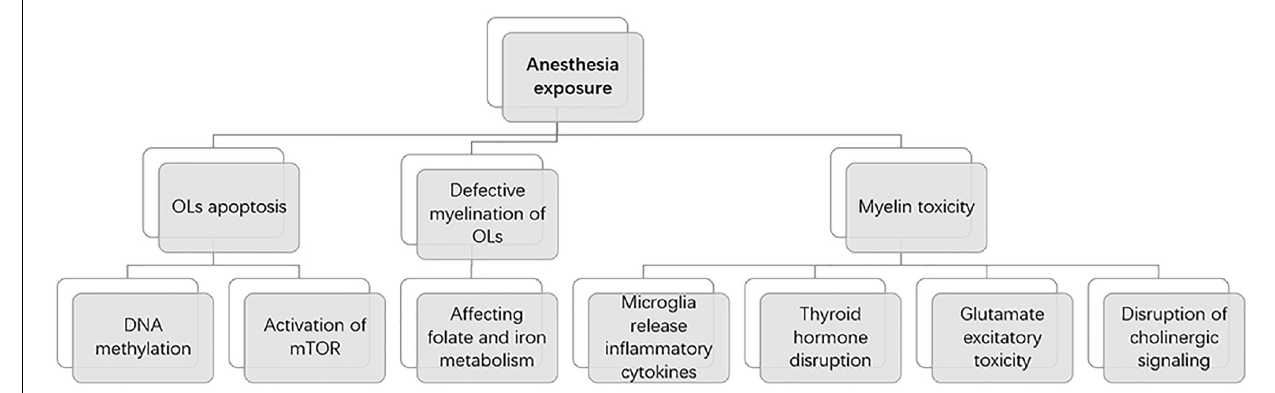
FIGURE 5 | Anesthesia exposure causes oligodendrocyte injury in the developing brain.